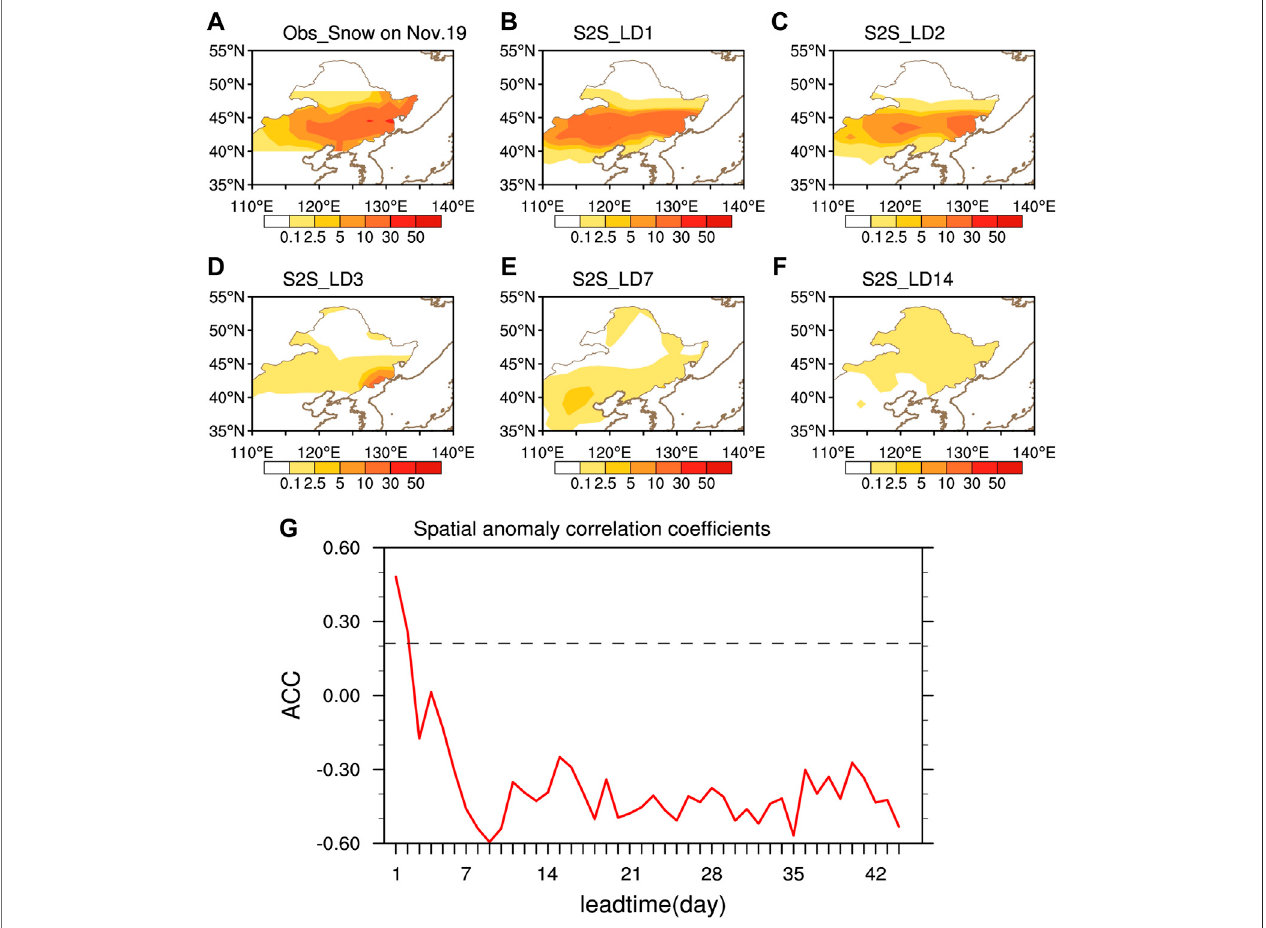
FIGURE11| The (A) observedsnowfall(unit:mm)on19November2020and (B – F) forecastensemblemeansnowfall(unit:mm)of16membersforleadtimesof (B) 1 day, (C) 2 days, (D) 3 days, (E) 7 days,and (F) 14 days (G) SpatialACCbetweenobservedandpredictedsnowfalloftheensemblemeanfromtheCFSv2S2SmodeloverNortheast China on 19 November 2020 as a function of forecast lead in days. The dotted line indicates the spatial correlation coef fi cients signi fi cant at the 90% con fi dence level.